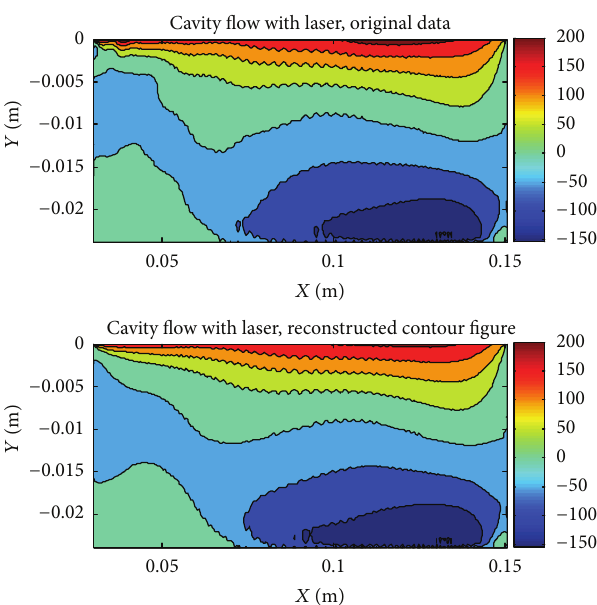
Figure 7: Original 𝑥 -velocity contour and reconstructed 𝑥 -velocity contour using 7 POD